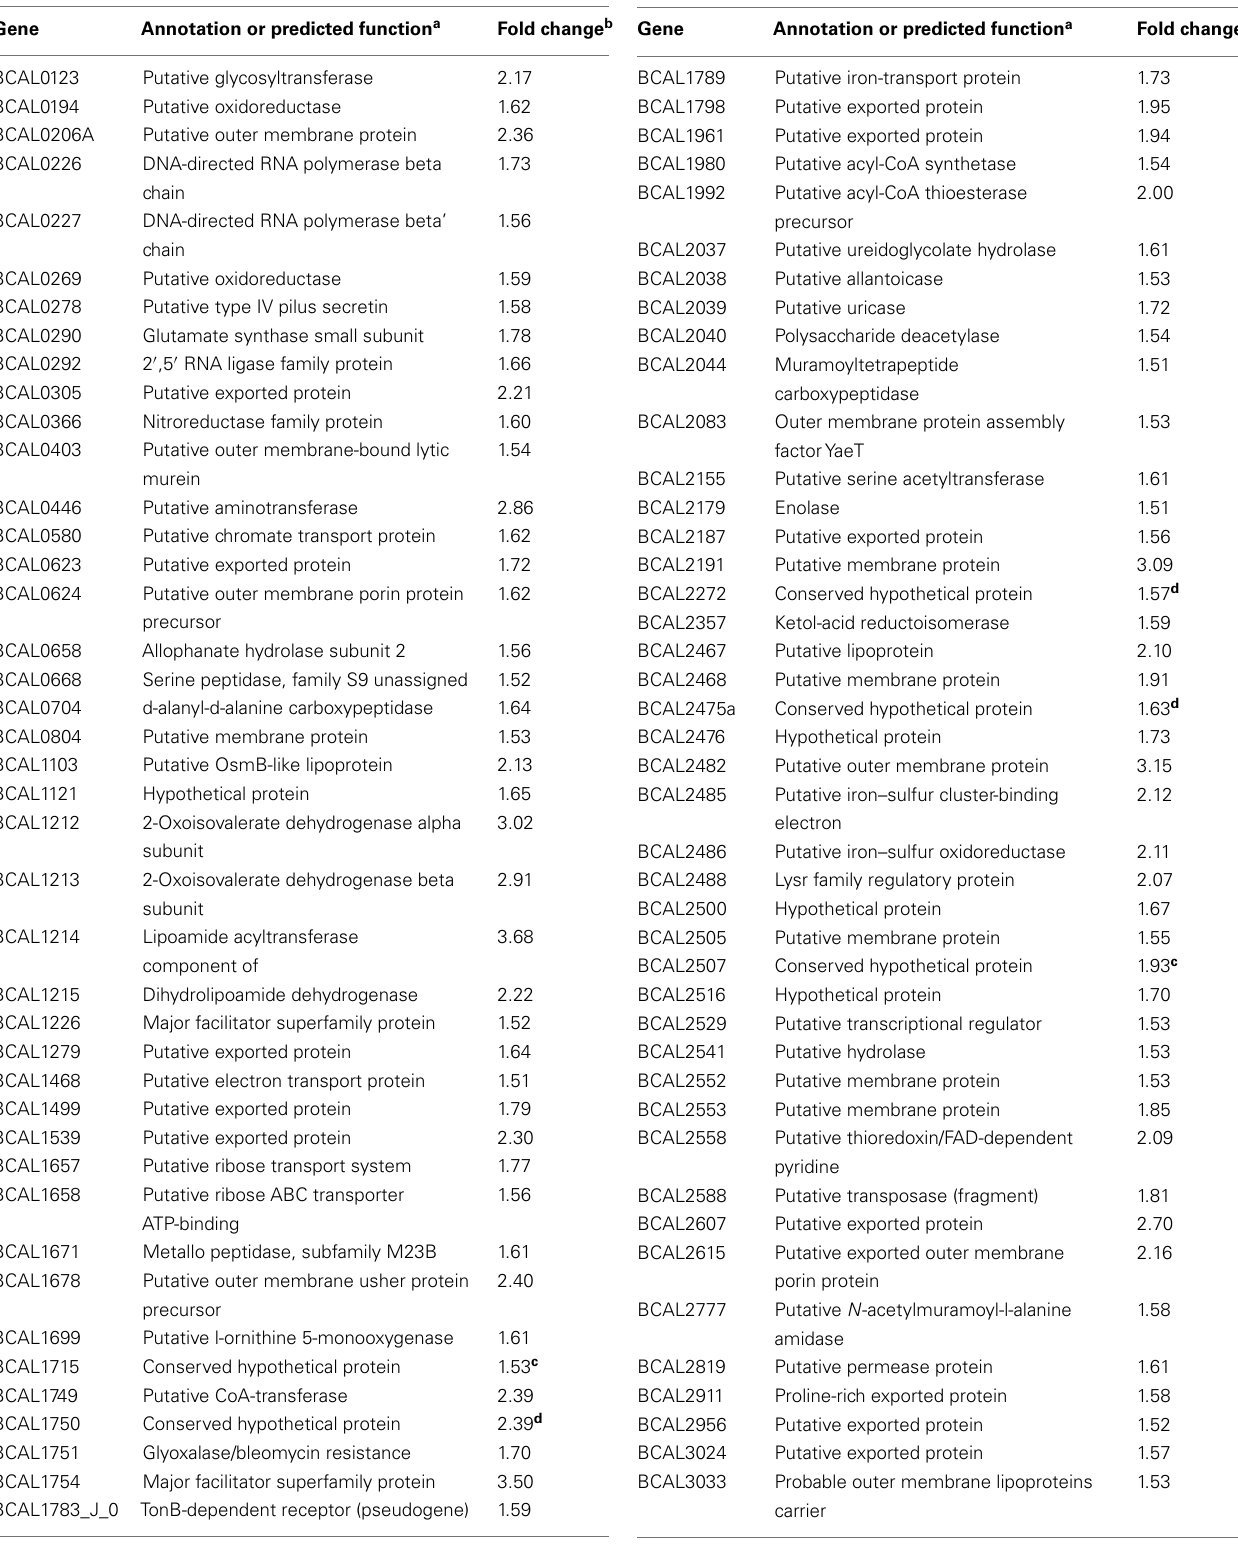
TableA1 | Burkholderia cenocepacia genes induced during chronic lung